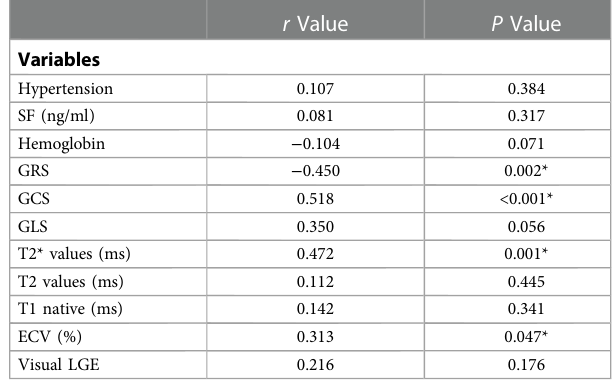
TABLE 2 Relationship between clinical and CMR parameters and LV dysfunction in all HIV-1